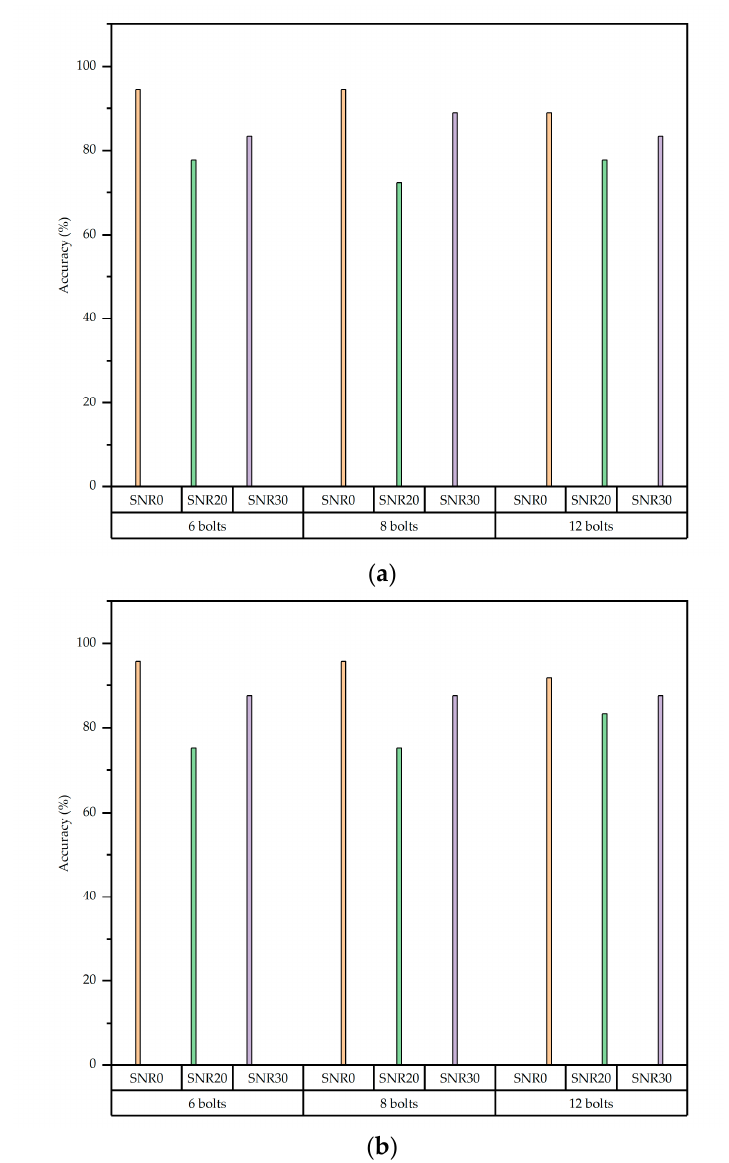
Figure 18. Multi-condition prediction accuracy comparison chart (continuous impulse load of equal amplitude); ( a ) 70% samples learning; ( b ) 60% samples learning.